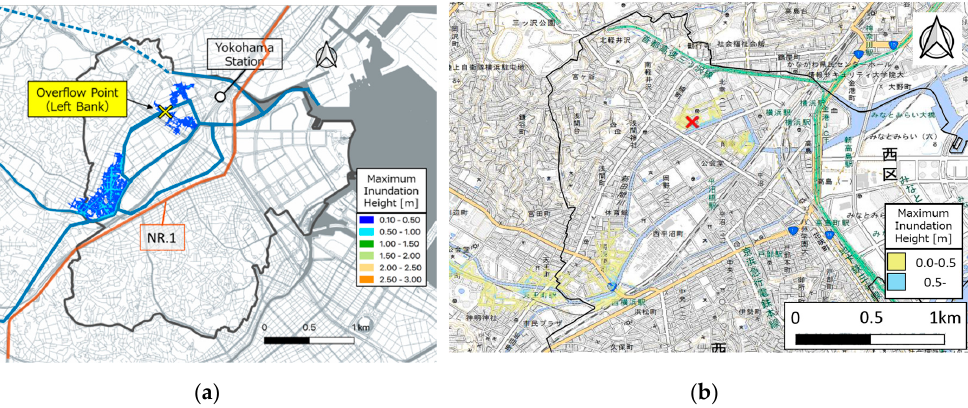
Figure 10. Comparison of the river water flooding calculation result and analysis result in the report on flooding hazard map production: ( a ) river water flooding analysis result; and ( b ) report on the flooding hazard map production.